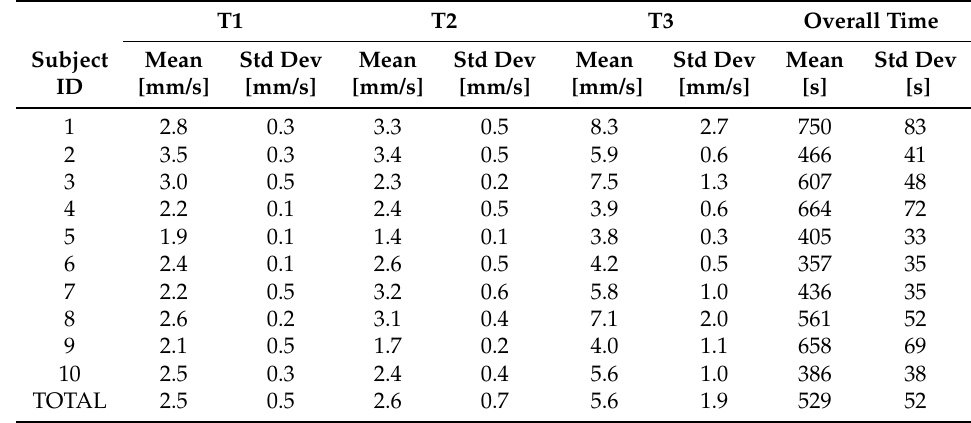
Table 5. Mean and standard deviation of the velocities to complete the tasks. T1 T2